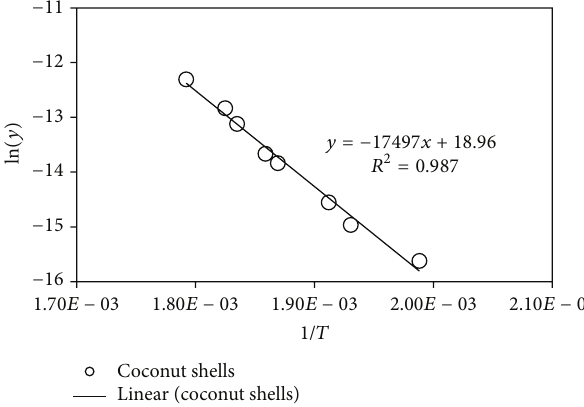
Figure 2: The graphs for determining kinetic